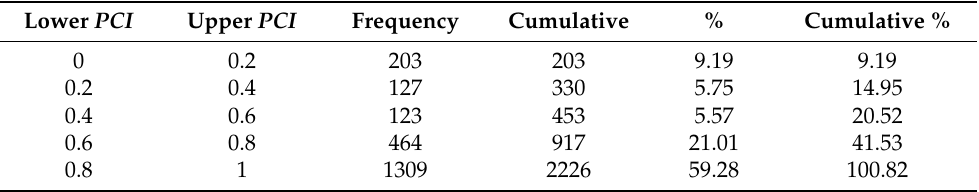
Table 4. Distribution of the pedigree completeness index ( PCI ) in the reference population (2010–2018).